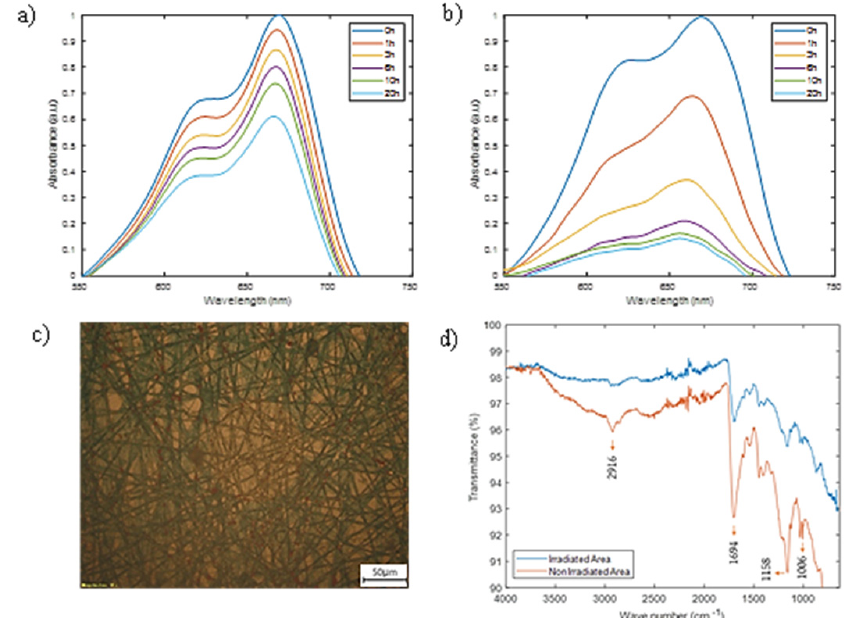
Figure 10. ( a ) Evolution of the degradation rate of MB deposited into sample S0 for a total irradiation time of 20 h; ( b ) evolution of the degradation rate of MB deposited into S4 sample for a total irradiation time of 20 h; ( c ) optical microscopy image of a micrometric degraded zone of the dye; ( d ) FTIR spectra of the irradiated and non-irradiated area of the Methylene Blue sample.